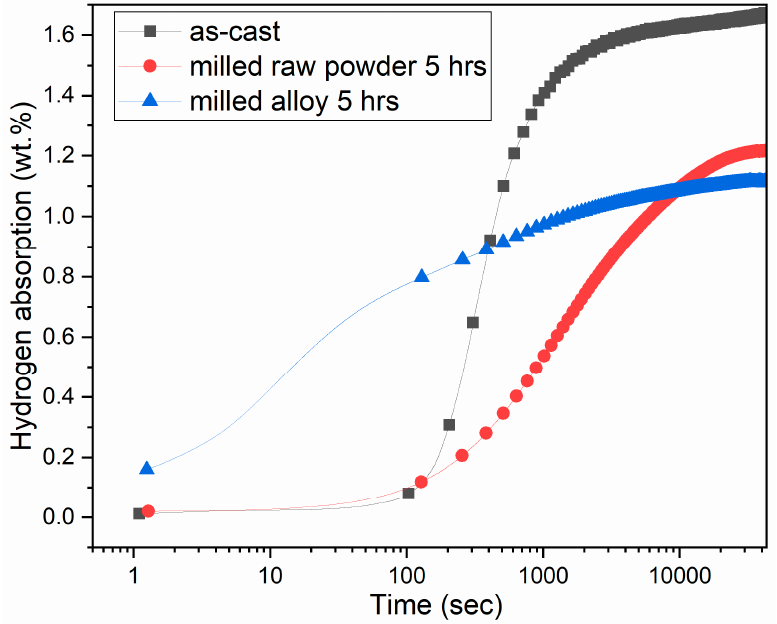
Figure 9. Activation curves of the milled raw powder for five hours, the as-cast alloy further milled for five hours, and the as-cast